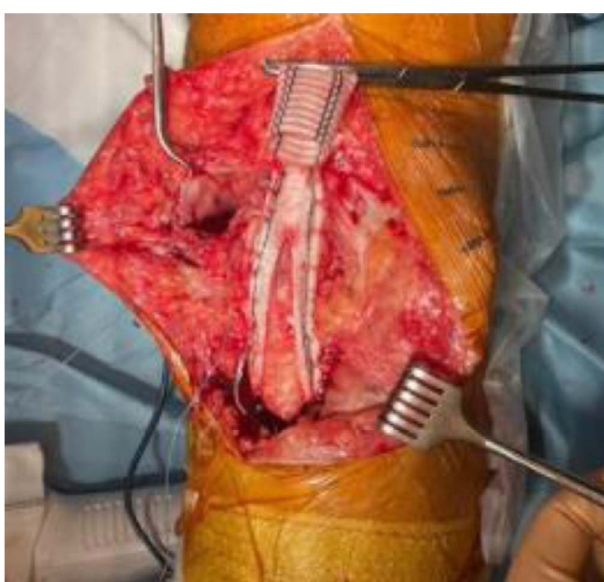
Figure 5. Augmentation with the Dacron vascular graft.